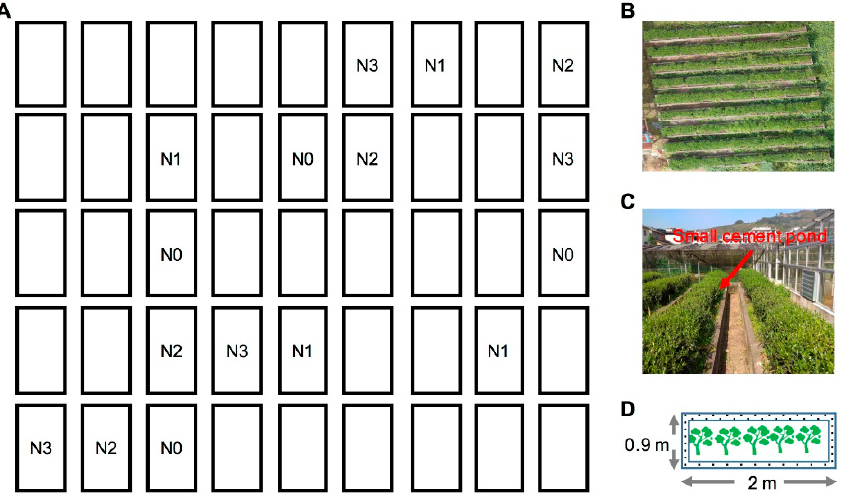
Figure 8. Designation of long-term nitrogen application location filed experiment in a tea garden. ( A ) Each independent small cement pool in the field (blanks are for other treatments); ( B ) Aerial image of the field trials; ( C ) Each plot isolated by concrete ponds; ( D ) The size of each experimental plot. For the tea garden in Fujian province, China, the average amount of chemical fer- tilizers is 266 kg/hm 2 N, 186 kg/hm 2 P 2 O 5 , and 193 kg/hm 2 K 2 O [14]. Therefore, four fertilization treatments were designed in this experiment, including N0 (0 N kg/hm 2 ),